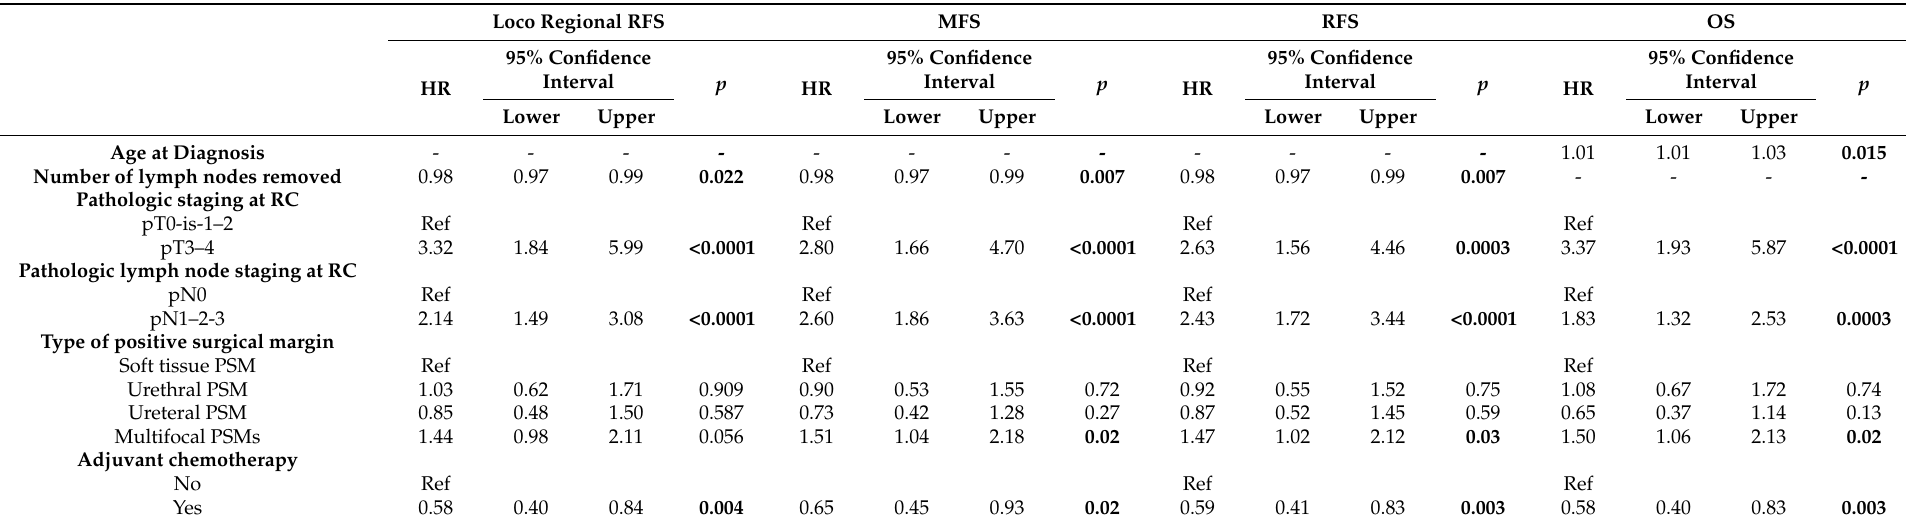
Table 3. Multivariable Cox regression analyses predicting oncological